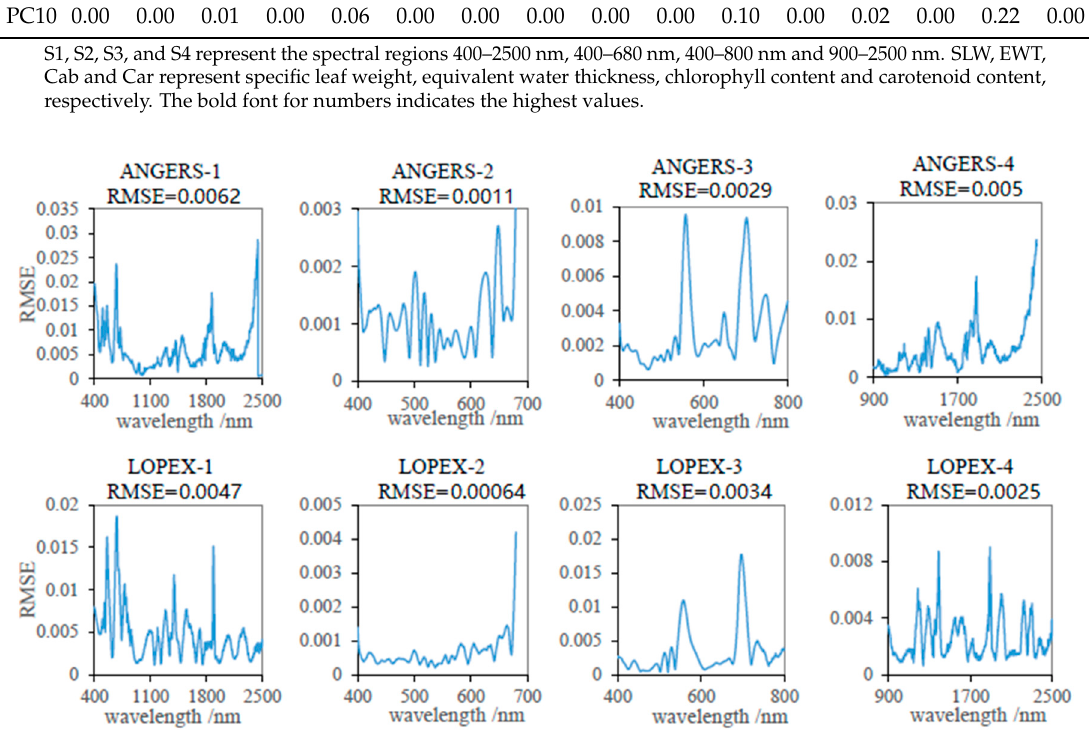
Figure 5. Spectral root mean squared error (RMSE) between measured leaf reflectance and reconstructed reflectance using the ten leading principal components (PCs) for different spectral regions. X-1, X-2, X-3 and X-4 represent the spectral regions 400–2500 nm, 400–680 nm, 400–800 nm and 900–2500 nm. RMSE is root mean squared error.